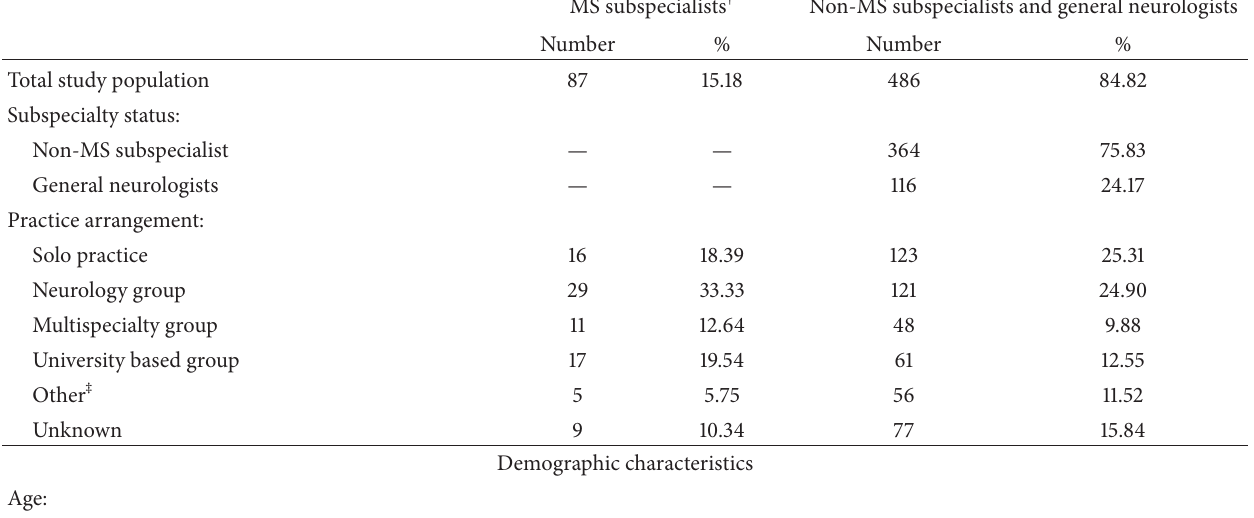
Table 1: Descriptive statistics for study